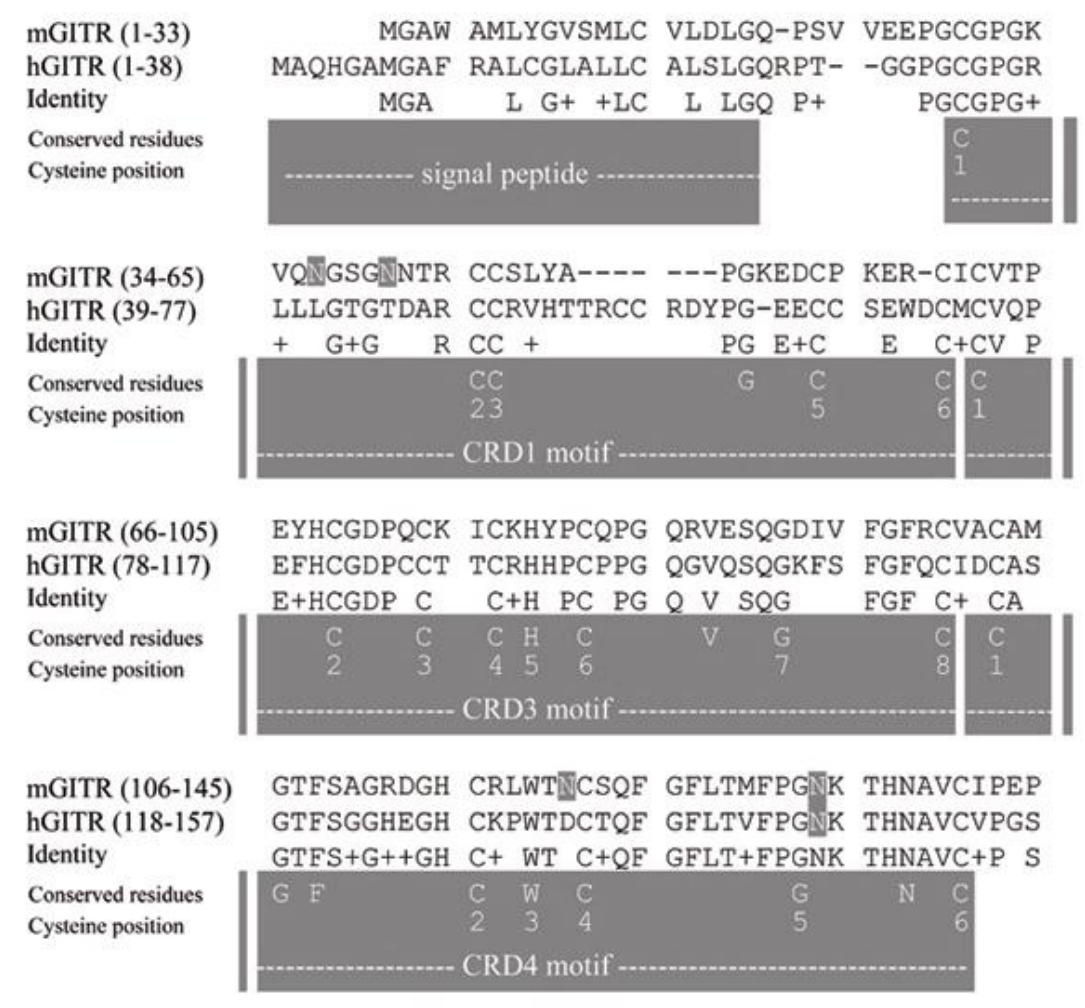
FIGURE 4. Homology between the extracellular domains of mouse and human GITR. Comparison between the extracellular domains of mGITR and hGITR. The amino acid position is reported between brackets. The Asparagine in white on gray background represents potential glycosylation sites. In the identity line, amino acid residues with similar function (I, V, M, L; H, R, K; E, D, N, Q; S, T; A, G; Y, F) present in both sequences are indicated by +. In the conserved residues line, the amino acid residues matching the respective CRD (see Table 3) are reported. Cysteine position in the CRD (or the position of the amino acid residue substituting the cysteine residue) is also reported.